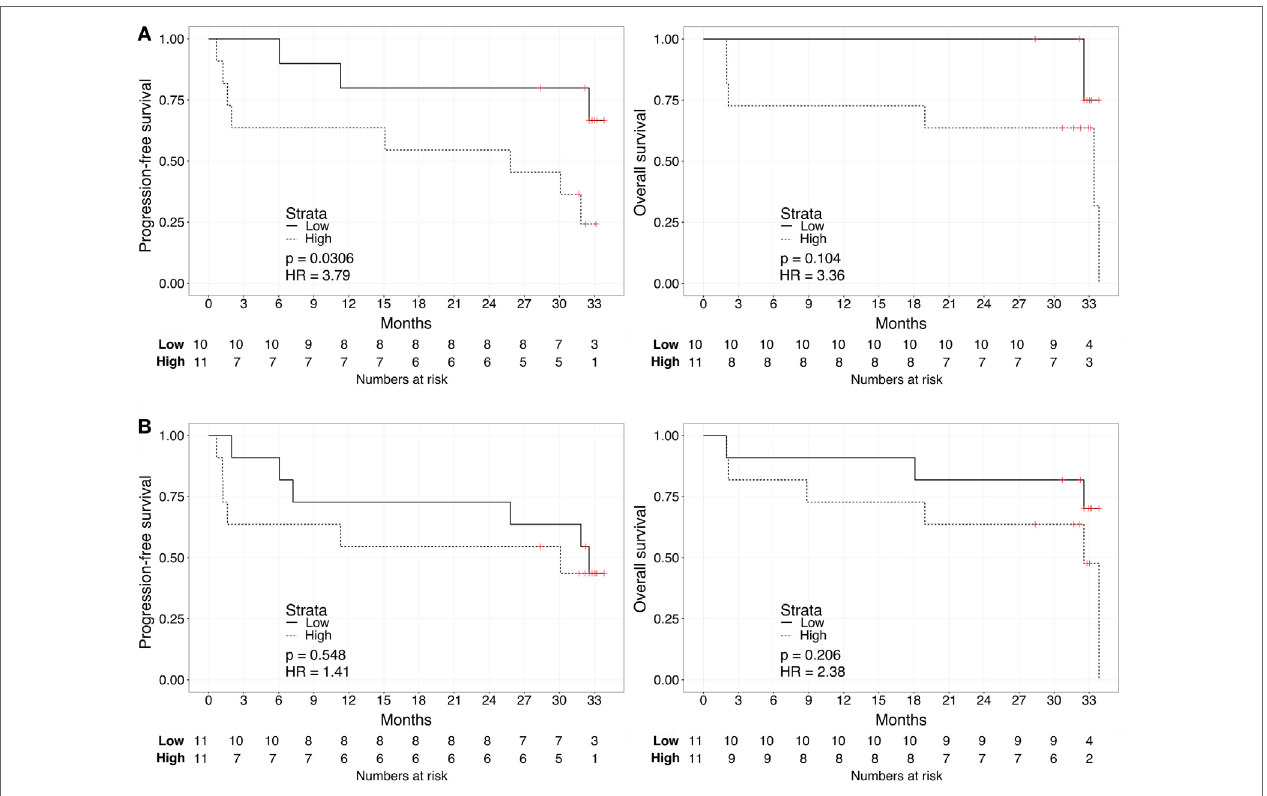
FigUre 3 | Kaplan–Meier curves for PFs (left) or Os (right) limited to patients with metastatic ccrcc according to the urine (a) or plasma (B) biomarker score level . The prospective cohort of patients ( N = 23) was classified as “Low” (solid) vs. “High” (dashed) biomarker score at the time of